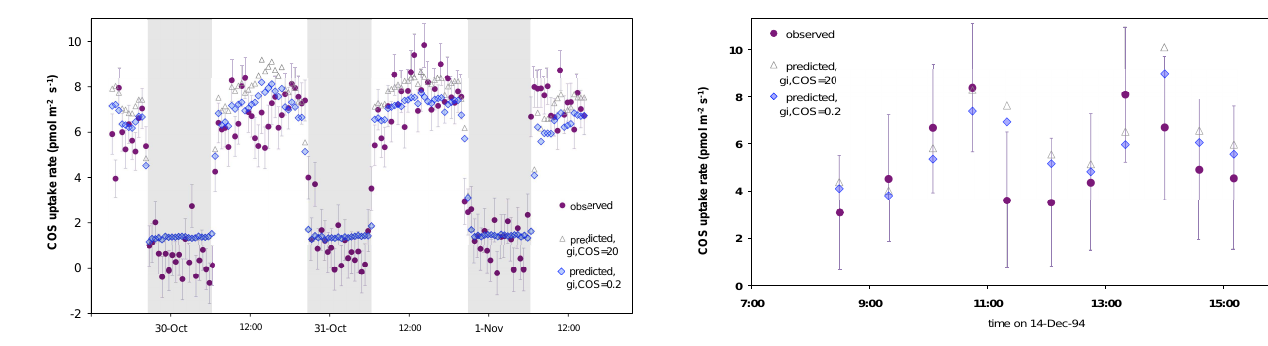
Fig. 2. Leaf COS uptake predicted from transpiration data (Eq. (4), assuming R w − COS =2 and constant internal conductance, g i COS =0.2), and observed COS uptake from measurements on Quercus agrifolia in field chambers (original data from Kuhn et al., 1999). For comparison, we also show predicted rates where inter- nal conductance is assumed to be a negligible limitation to COS diffusion ( g i COS